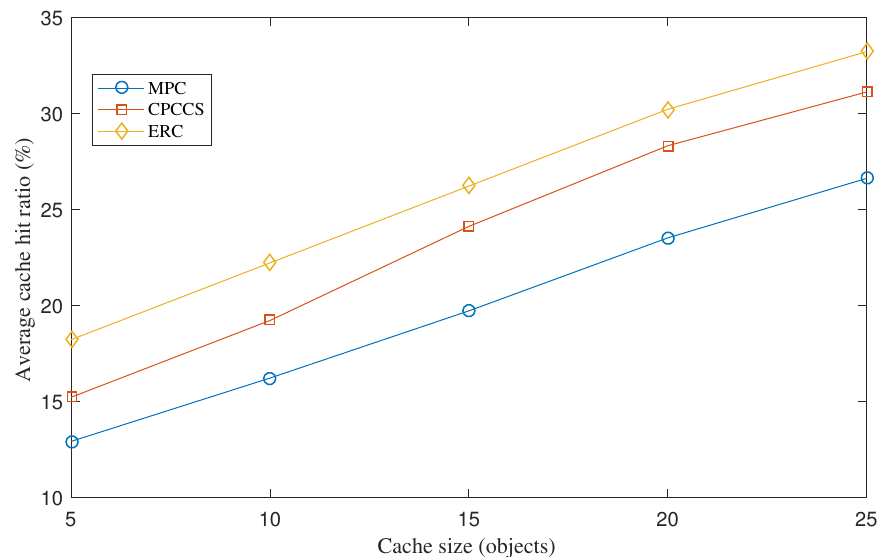
Figure 5. Average cache hit ratio under various cache